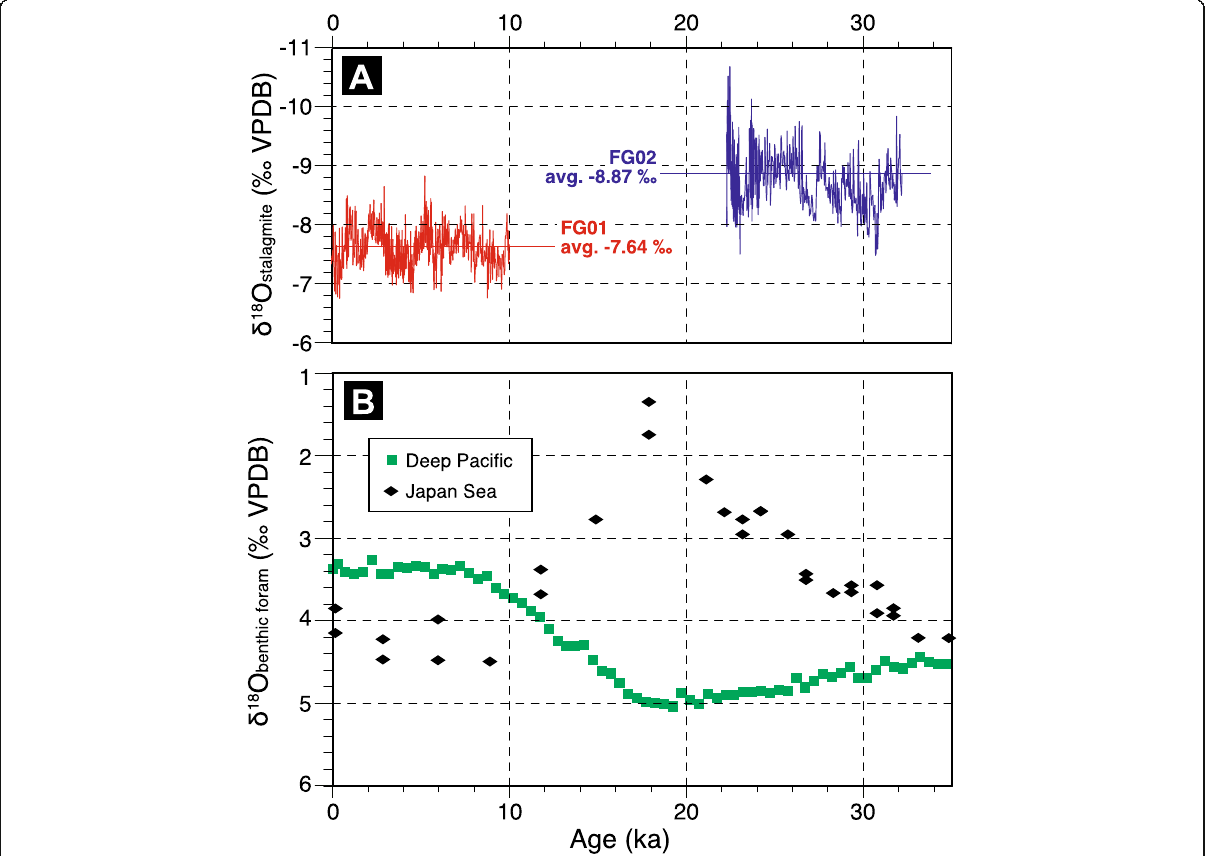
Fig. 8 Isotopic evidence of 18 O depletion in the Japan Sea during the last glacial period. a δ 18 O in stalagmites from Fukugaguchi Cave (FG01, Sone et al. 2013; FG02, this study). b Benthic foraminifera δ 18 O from a coring site at 330 m depth in the Japan Sea (Sagawa et al. 2018) and Northwestern Pacific Ocean (Lisiecki and Stern 2016). Both sets of isotopic data incorporate variability in water δ 18 O W and